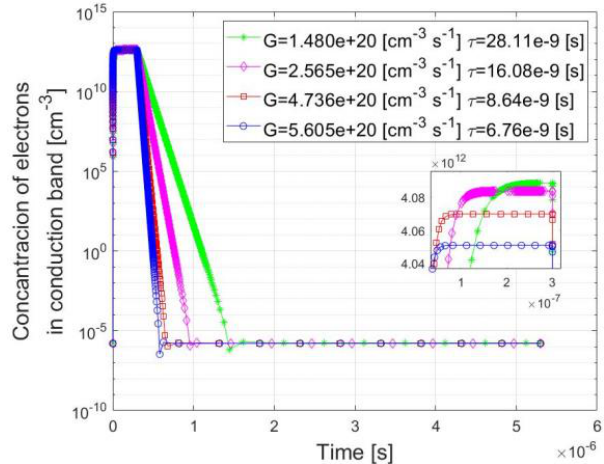
Figure 5. Changes in the concentration of electrons in the conduction band over time for the value of the generation coefficient corresponding to the results of experimental tests of the GaP-1 sample. The y -axis is presented on a logarithmic scale. The inset shows an approximation of the first 300 ns. At time zero, the lighting of the sample is turned on. Measurements carried out at a temperature of 300 K.